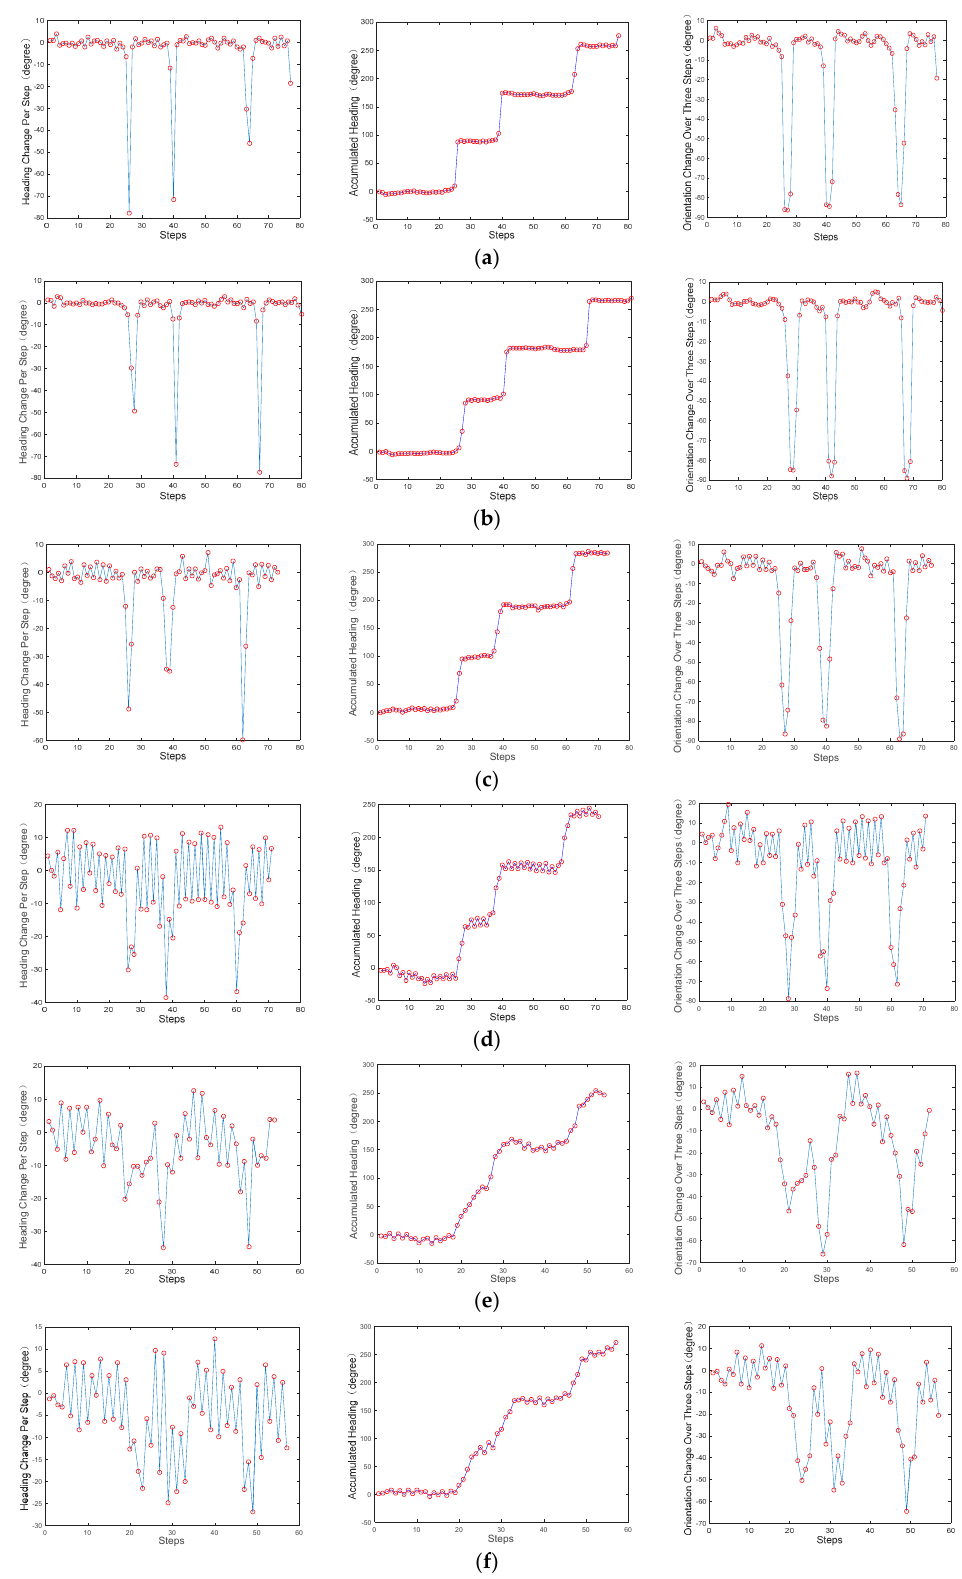
Figure 12. Heading estimation of six participants. The first column is the heading change relative to the last time stamp. The second column is the heading change relative to the start orientation. The third column is the third turn. ( a ) F1(Zhu); ( b ) F2(Zhou); ( c ) M1(Guo); ( d ) M2(Ma); ( e ) M3(Liu); ( f )